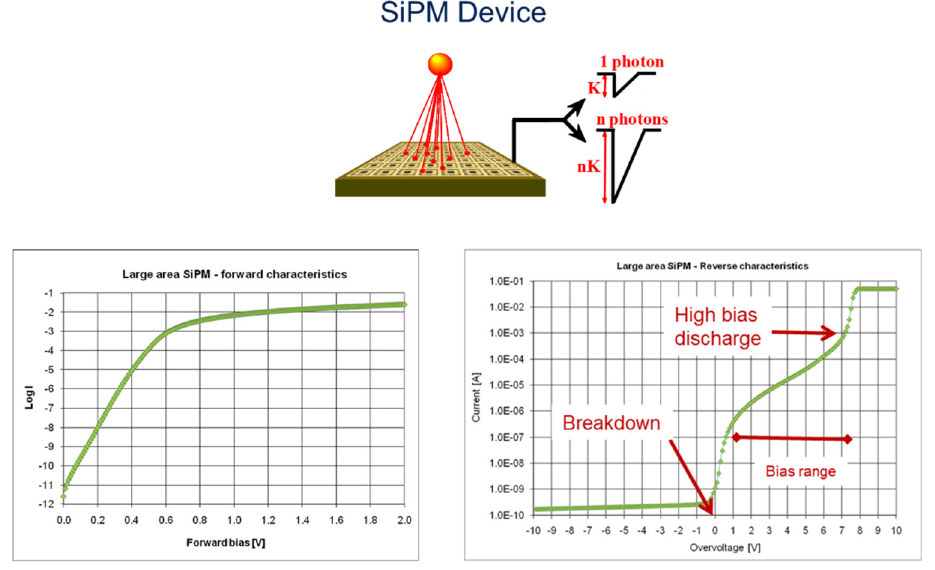
Figure 3. SiPM electrical diagrams.